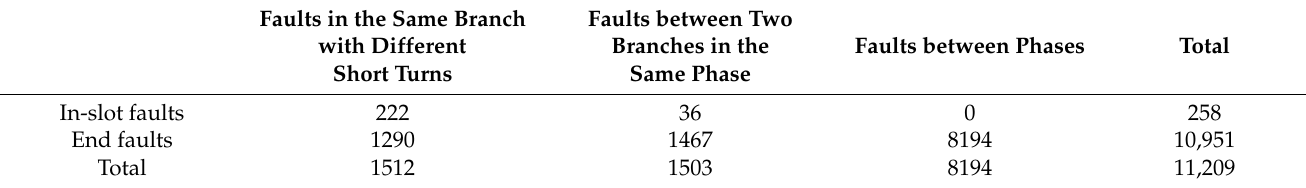
Table 4. The actionable protection number statistical results of the proposed